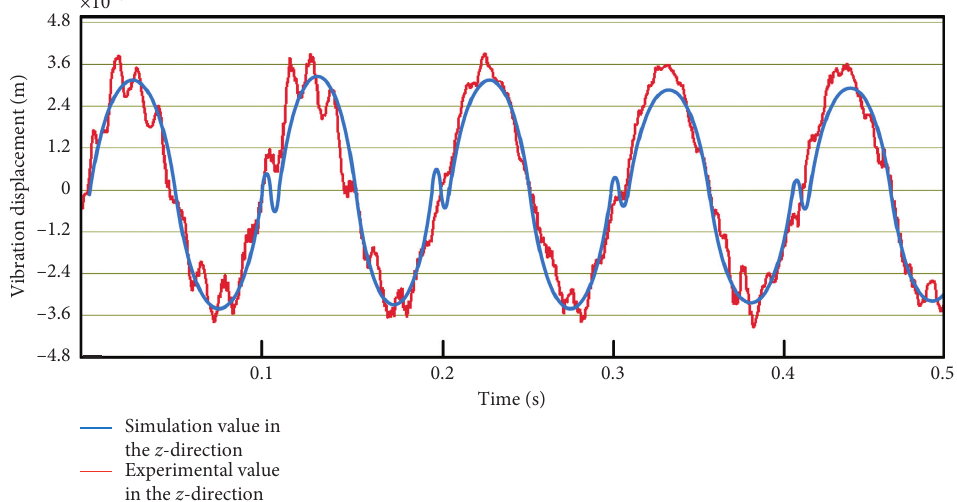
Figure 14: Comparison of experimental values and simulated values of axial vibration displacement at